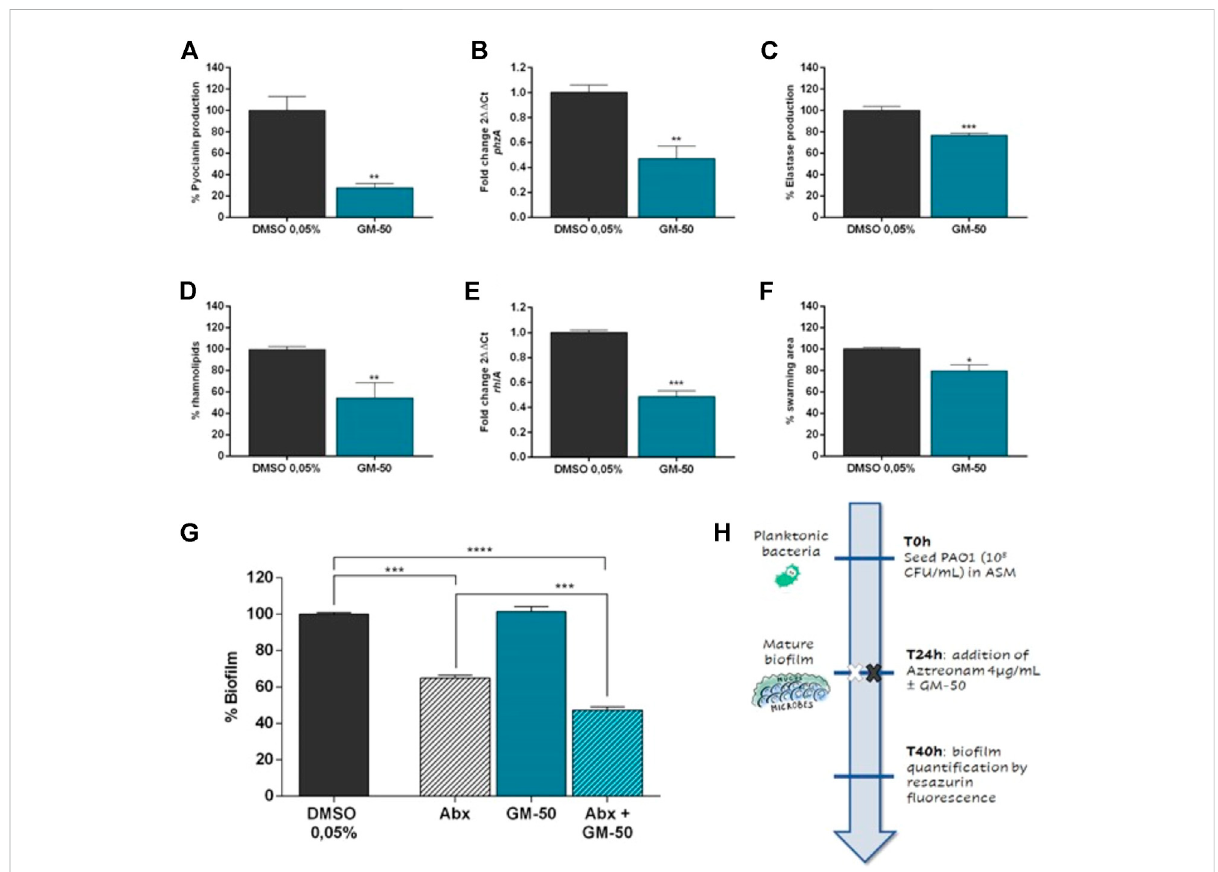
FIGURE 4 EffectofGM-50onPA01virulencefactorsexpression.PAO1(10 6 CFU/ml)wasculturedinLBwithGM-50(100 µM)orDMSO0.05%(vehicle)for 24 h at 37 ° C. After incubation, supernatants were used to quantify (A) pyocyanin production by chloroform-HCl method, (C) elastase production by Elastin-Congo red assay, (D) rhamnolipids release by methylene blue staining. (B,E) Transcript levels of phzA and rhlA , genes involved in pyocyanin and rhamnolipids production respectively, were assessed by qRT-PCR. (F) To evaluate swarming, PAO1 cultures were inoculated on the center of LB-agar plates (0.5% agar) and incubated at 37 ° C. We then evaluated the distance from the center. PAO1 + DMSO 0.05% was used as positive control and was arbitrarily set at100%. (G) PAO1 (10 6 CFU/ml) was cultured inASMfor 24 h at37 ° C with moderate agitation (75 rpm) to form bio fi lm. PAO1 mature bio fi lm was treated with aztreonam (Abx, 4 μ g/ml), GM-50 (100 µM), or aztreonam (Abx, antibiotic) and GM-50 for 16 h. Residual bio fi lm was then evaluated by measuring the relative fl uorescence units (RFU) using a fl uorimeter (Ex = 530 – 570 nm, Em = 590 – 620 nm). Data are reported as thepercentageof bio fi lm calculated by setting DMSO as 100%.Data are represented as mean ± SEM, n =3 experiments. * p < 0.05, ** p